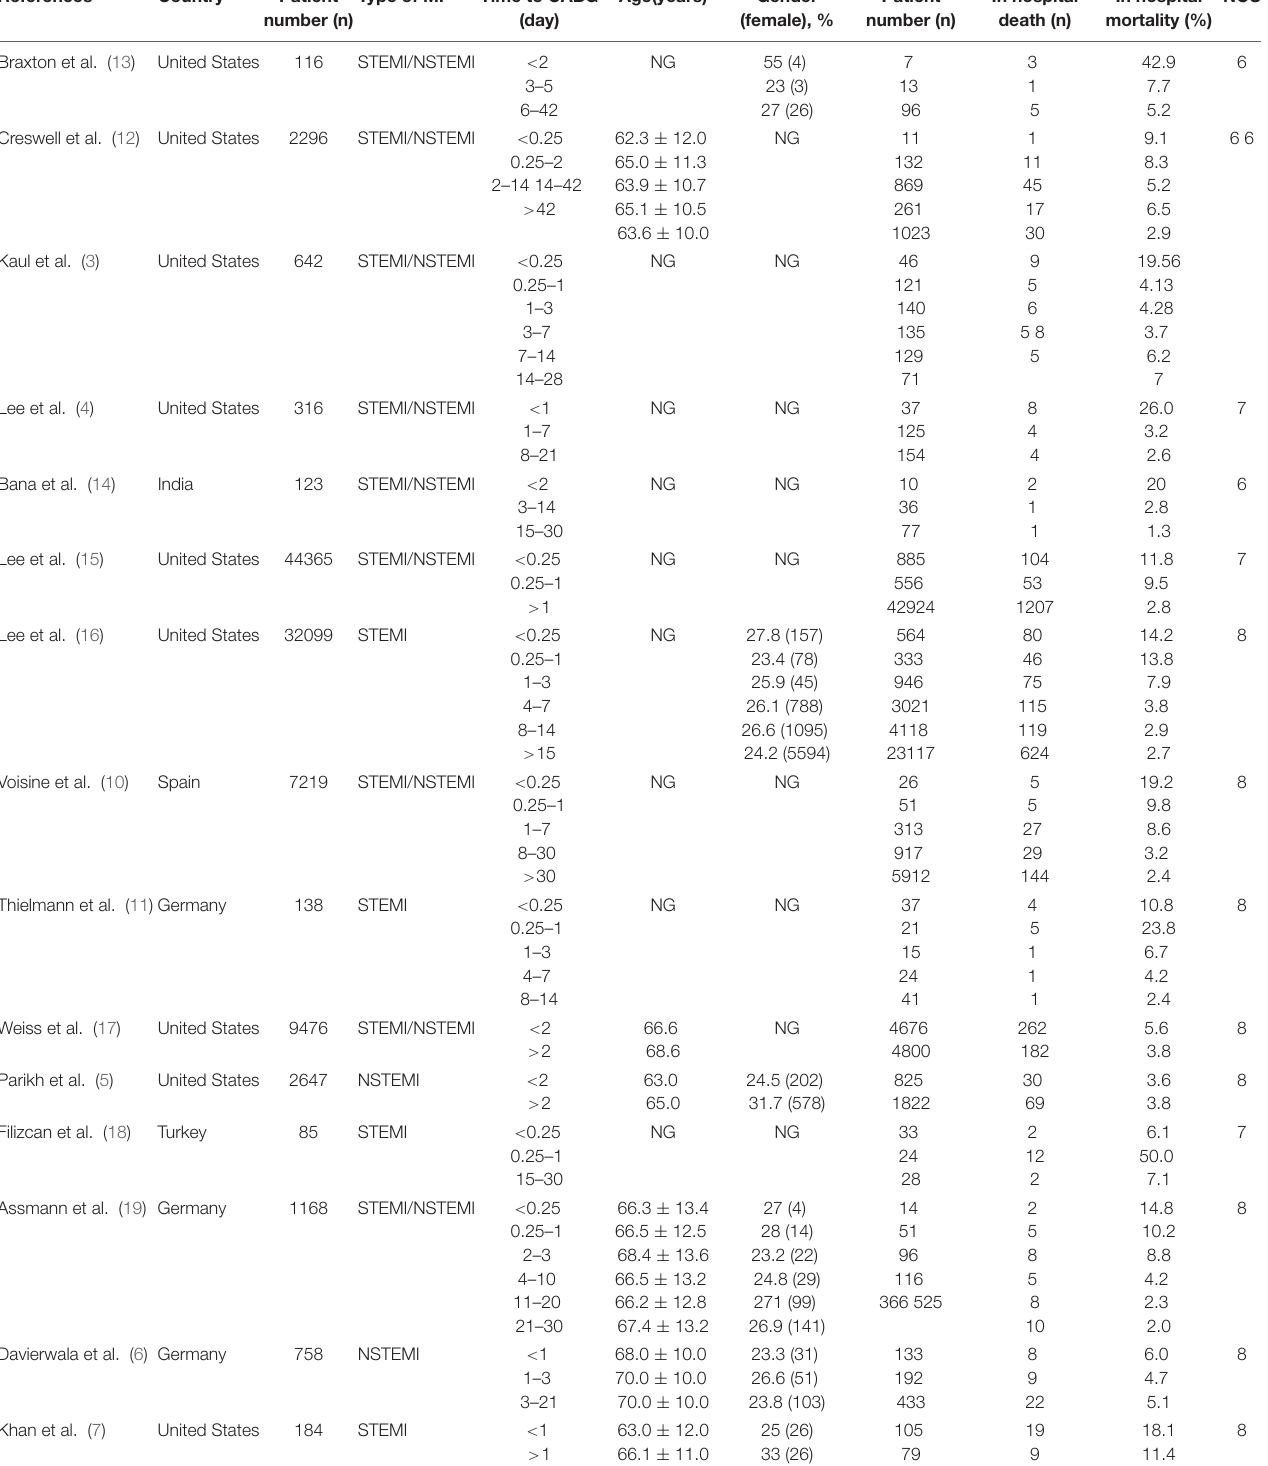
TABLE 1 | Characteristics of the included